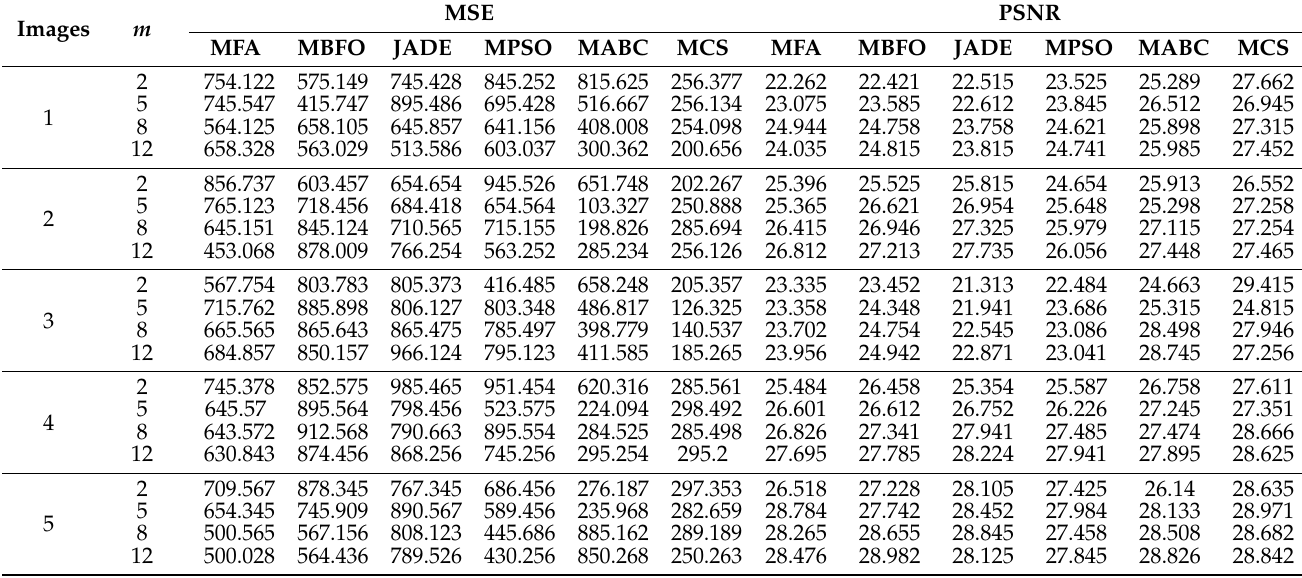
Table A9. MSE and PSNR computed using different optimization algorithms with the proposed R é nyi-MCS. Images